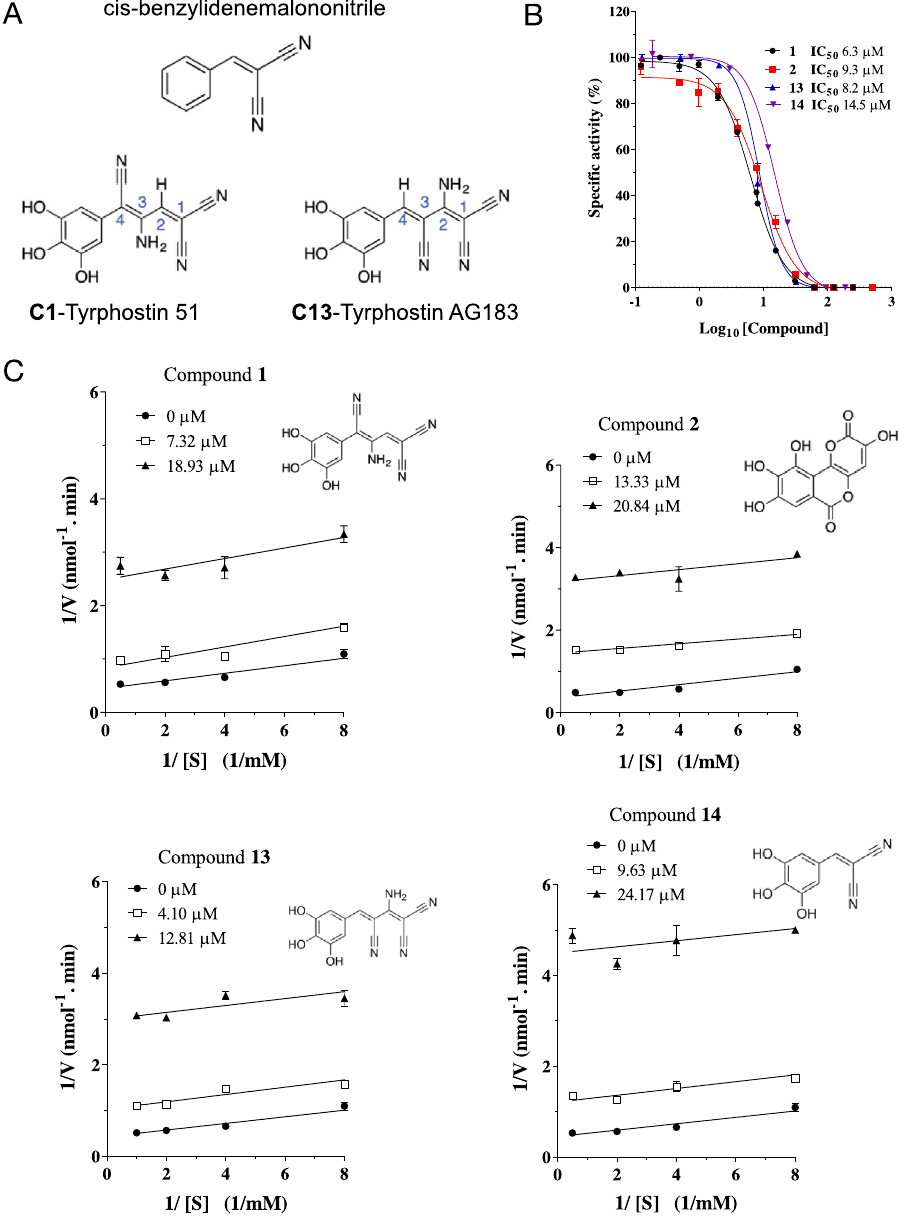
Figure 2. Dose–response curves and mode of inhibition for selected compounds. Compounds 1 , 2 , 13 and 14 were tested using the p NPP assay. ( A ) Common cis-benzylidenemalononitrile scaffold structure of the tyrphostin inhibitors and two examples compound 1 (C1) and 13 (C13). ( B ) Percentage of specific activity is calculated relative to the amount of p -nitrophenol released in the absence of inhibitor. Error bars represent ± SD of two independent experiments. ( C ) Mechanism of inhibition of SapM. Lineweaver–Burk plots for 1 , 2, 13 and 14 . Error bars represent ± SD of